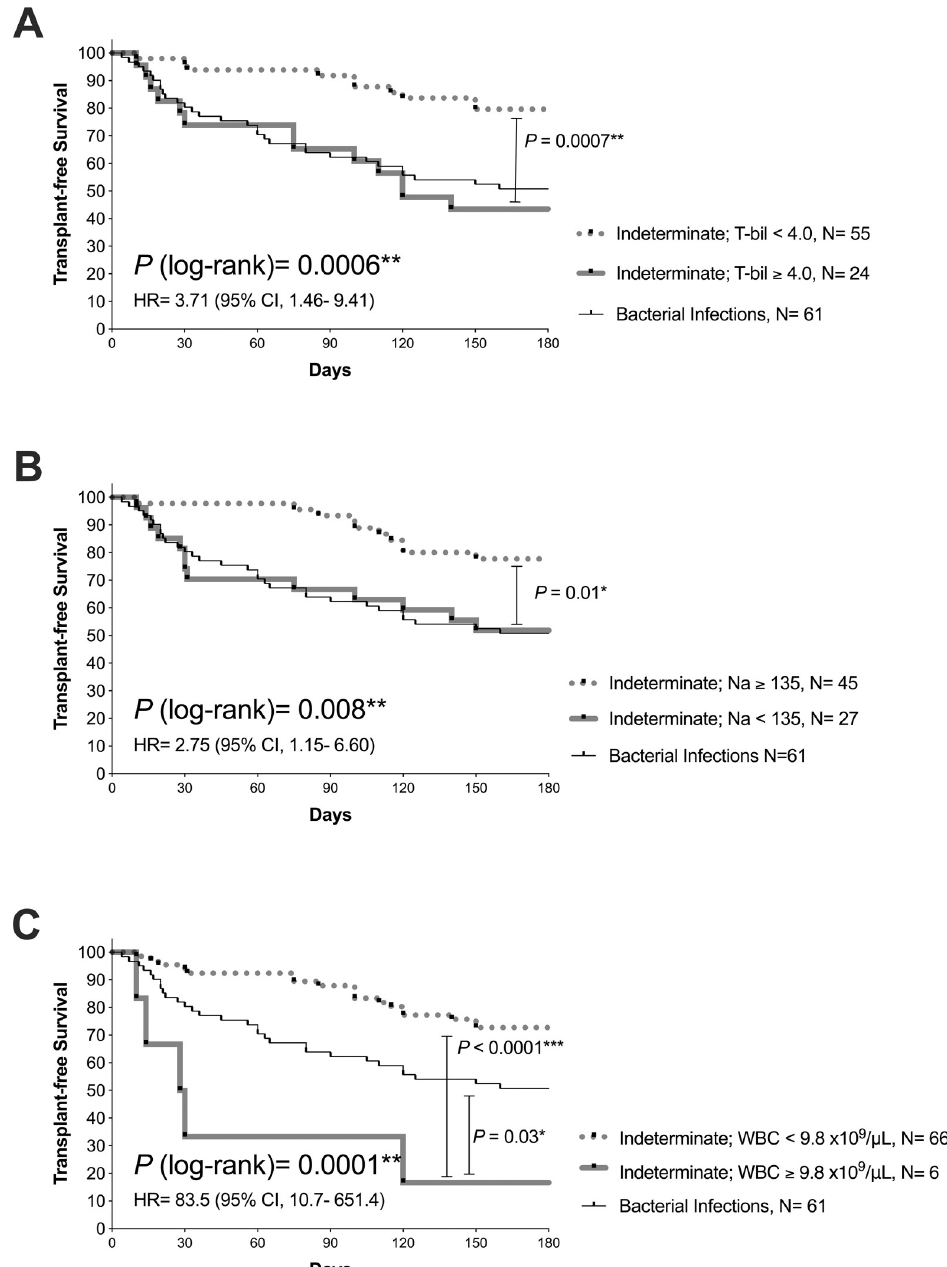
Fig 3. Survival analysis for 180-day transplant-free survival in AD/ACLF IND stratified by clinical parameters. Survival analysis by the Kaplan-Meier method of patients with their first indexed AD/ACLF induced by any indeterminate factors (AD/ACLF IND ) stratified by levels of serum total bilirubin (panel A), serum sodium (panel B), and white blood cell counts (panel C) are shown. The survival curves of AD/ACLF BAC are also demonstrated for comparison. P -values analyzed by log-rank tests are shown. � P < 0.05; �� P < 0.01; ��� P < 0.0001.